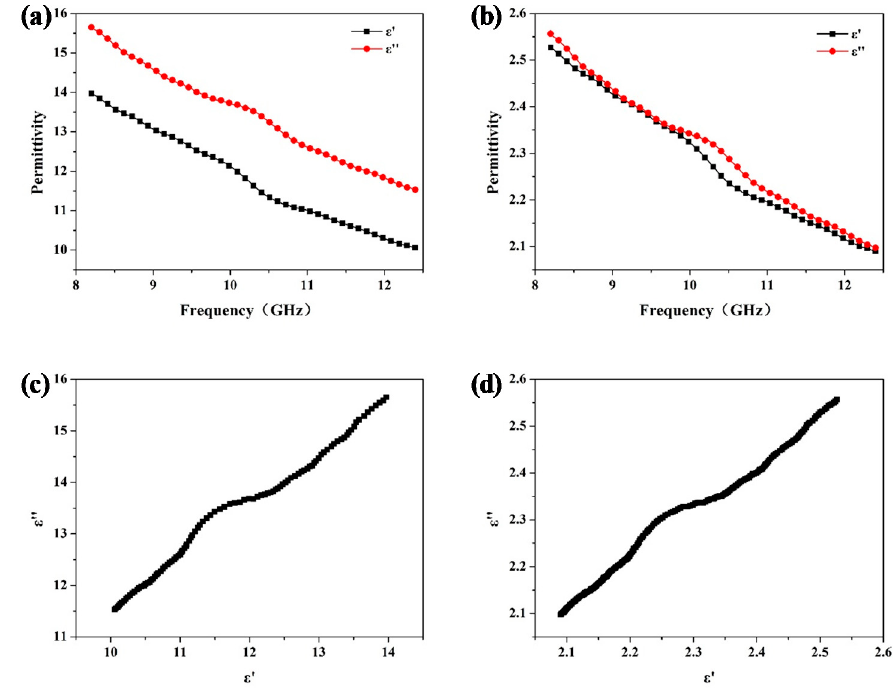
Figure 4. Dielectric properties ( a , b ) and cole–cole diagram ( c , d ) of the coated lossy material and corresponding honeycomb.